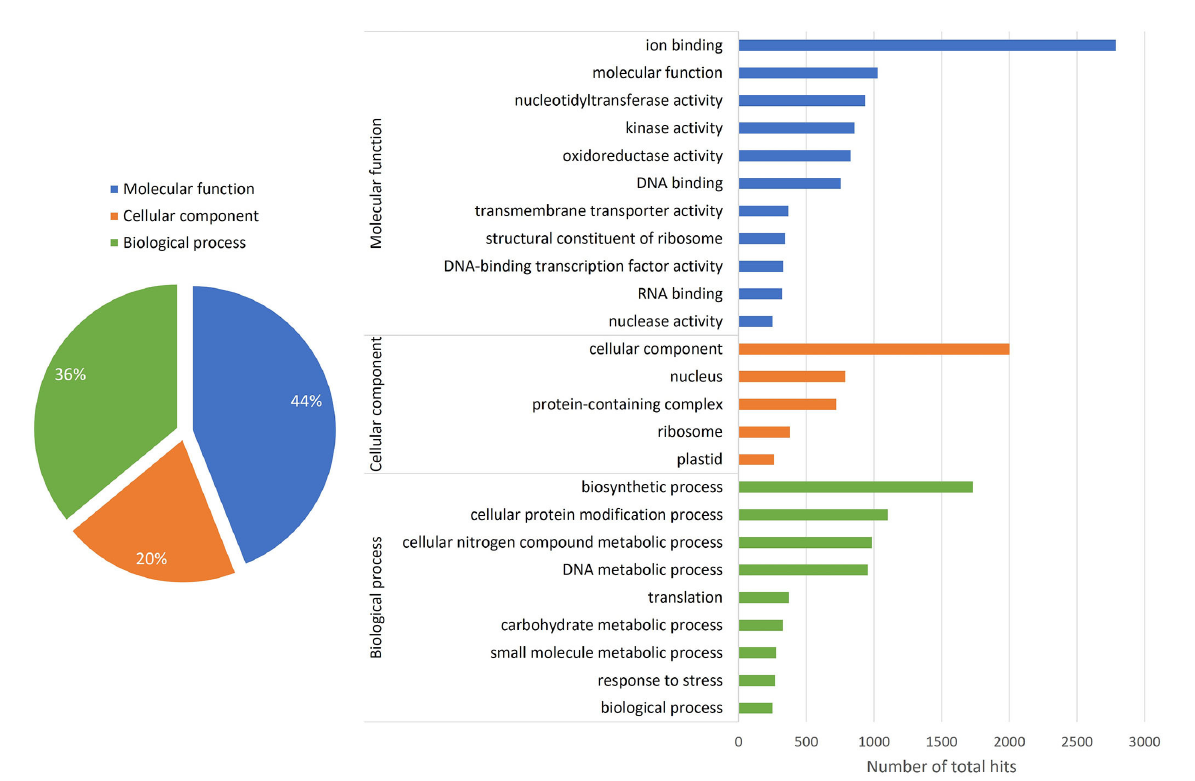
FIGURE3 Classification of contigs under Gene Ontology terms. A total of 11,825 contigs were assigned with G.O. terms within the three main categories (Biological process, Cellular components, and Molecular function) and subdivided into their corresponding subcategories. Only relevant G.O. categories ( ≥ 100 hits per subcategory) are